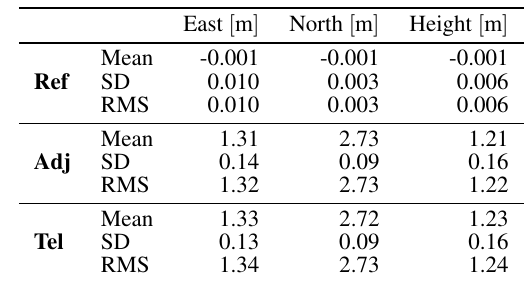
Table 8. Statistics of the differences between the GCPs/CPs coordinates estimated by the reference (Ref), “adjusted” (Adj), and “telemetry” (Tel) solutions and the ones observed by the Leica MS60 multistation.